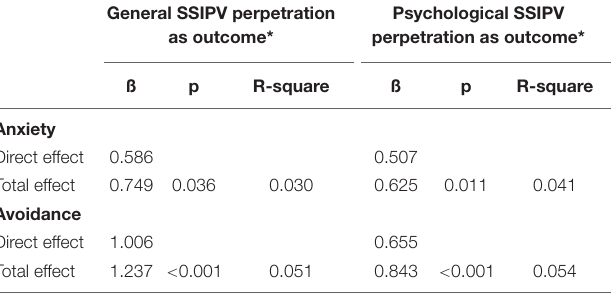
TABLE 4 | Defined